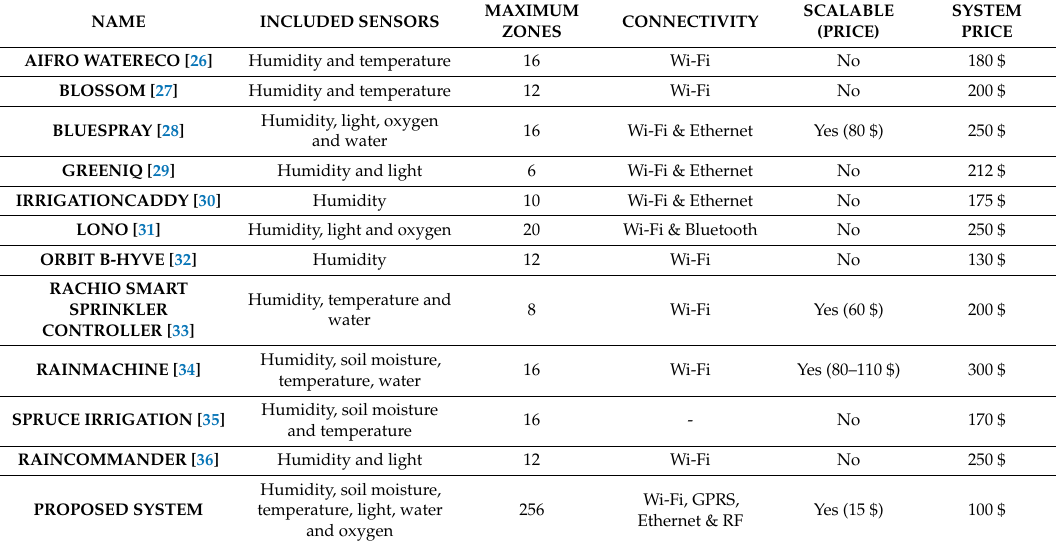
Table 4. Comparative between the proposed solution and the main commercial solutions currently available on the